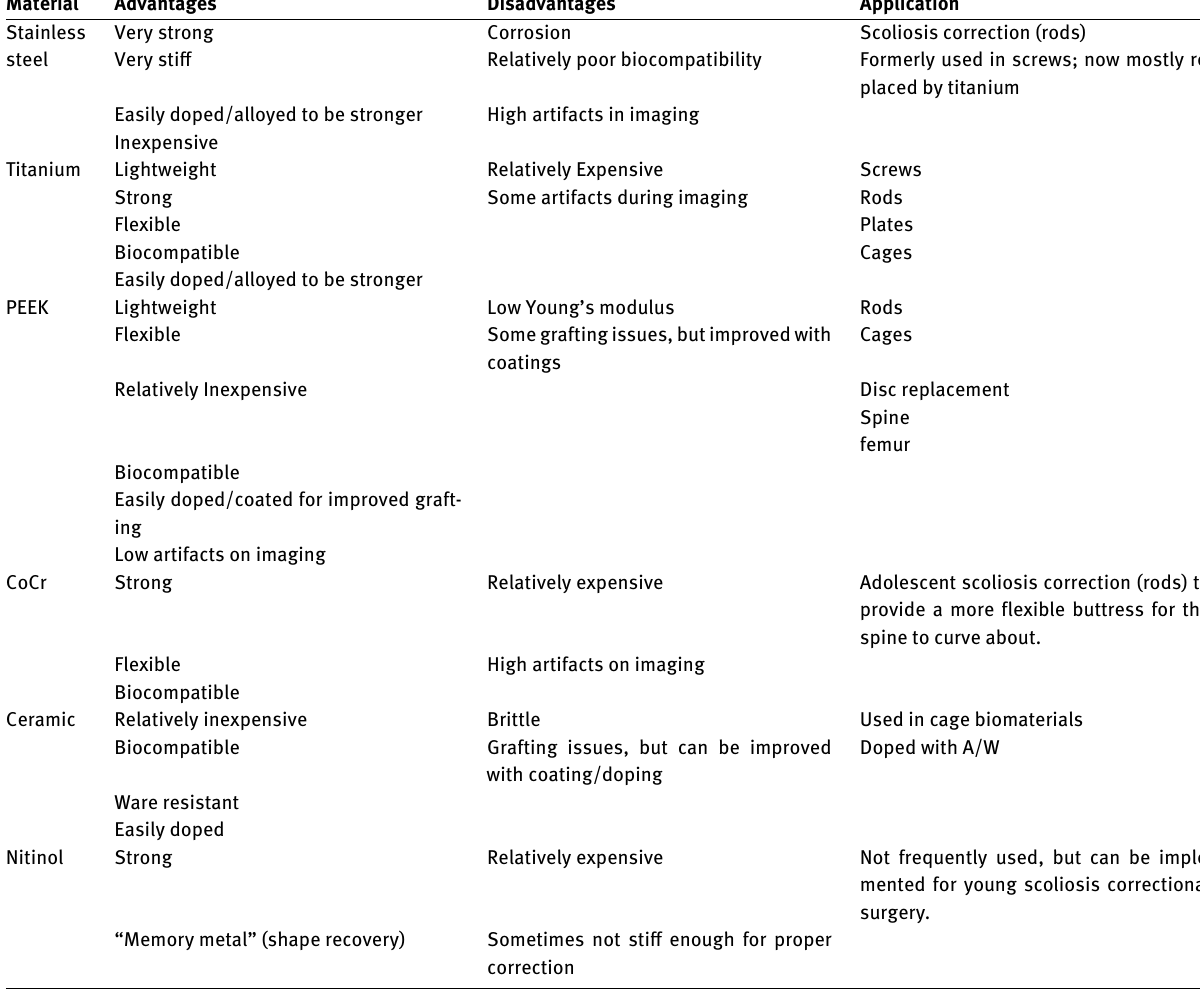
Table 1: Characteristics of